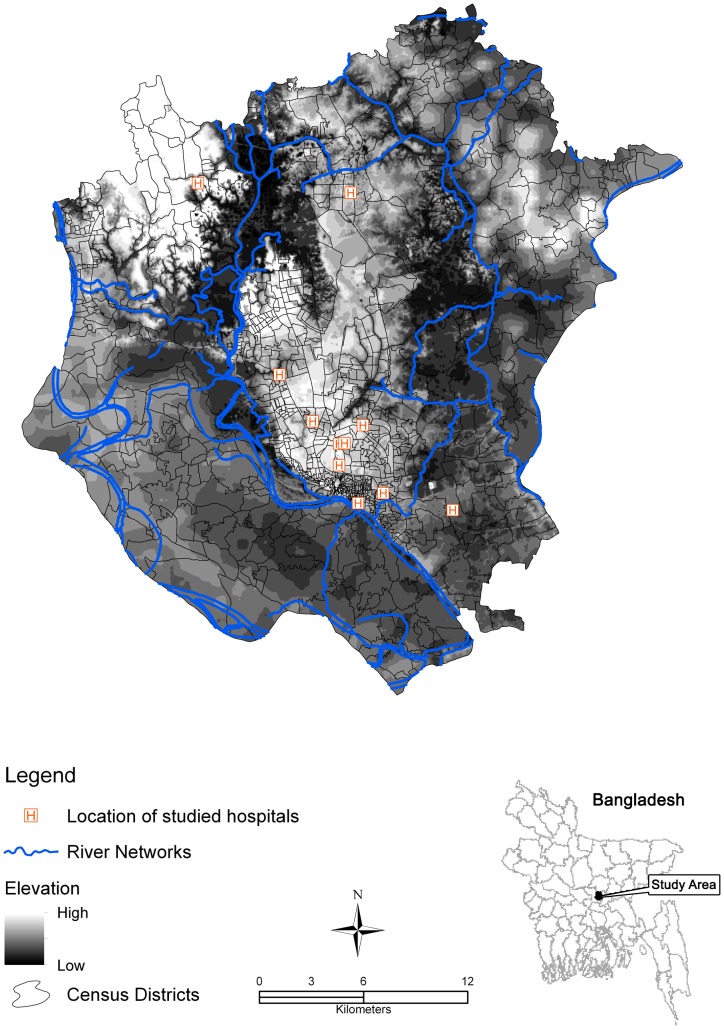
The Dhaka Metropolitan Area (DMA).